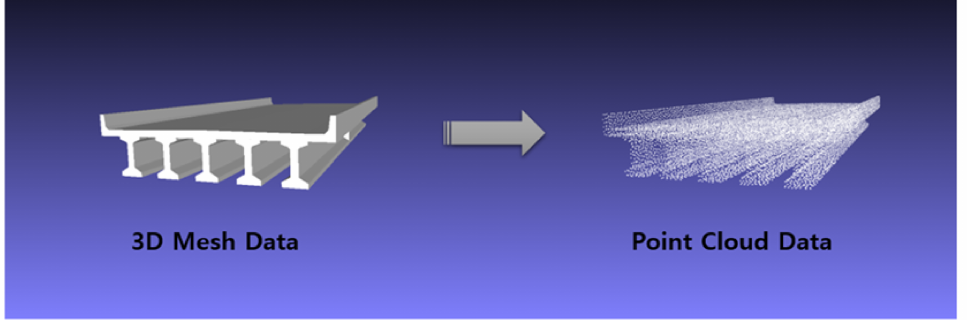
Figure 15. Converting 3D mesh data to point cloud data.